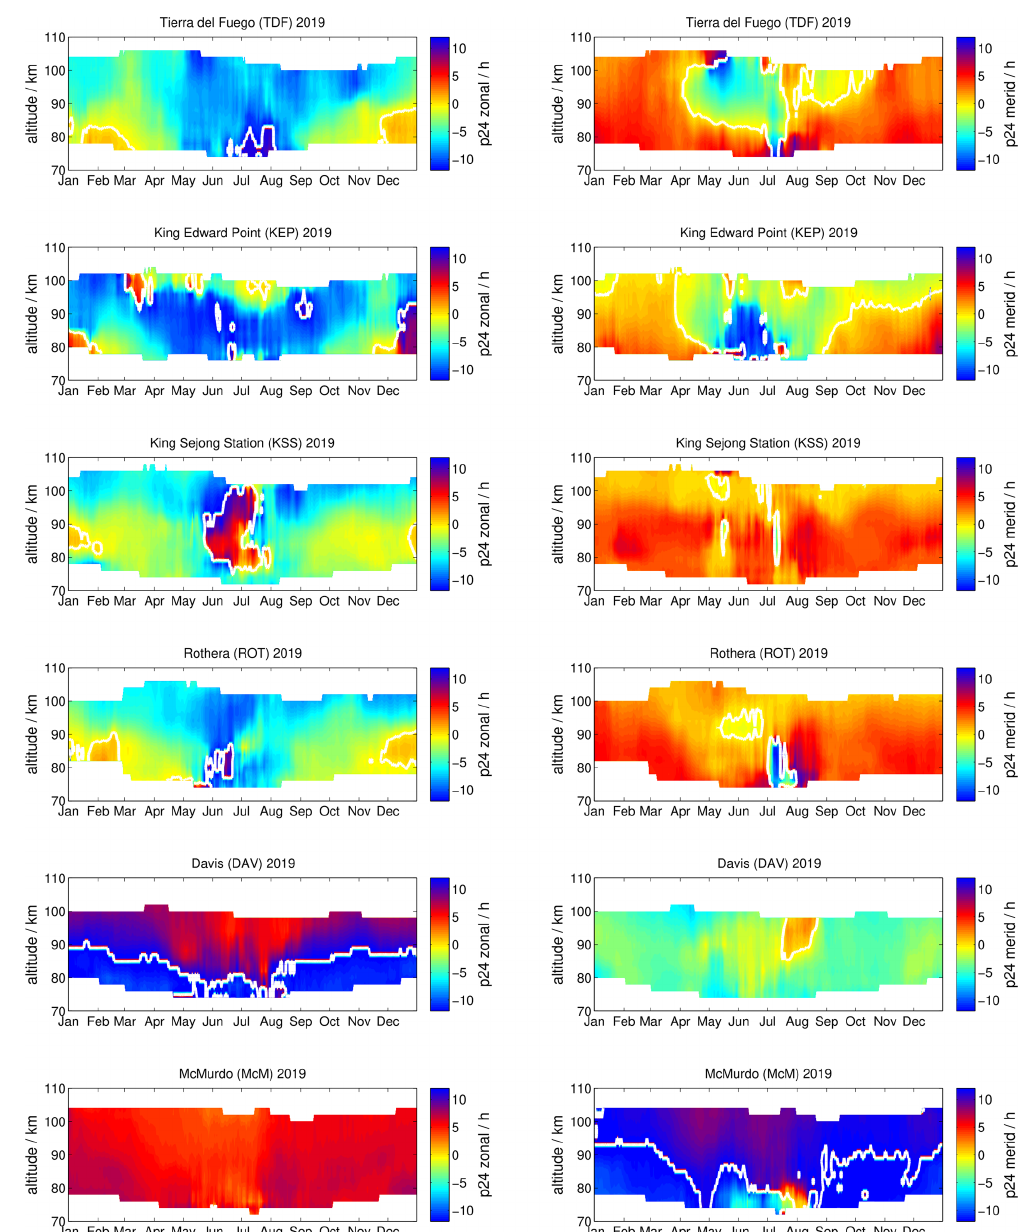
Figure 4. Same as Fig. 2 but for the diurnal tidal